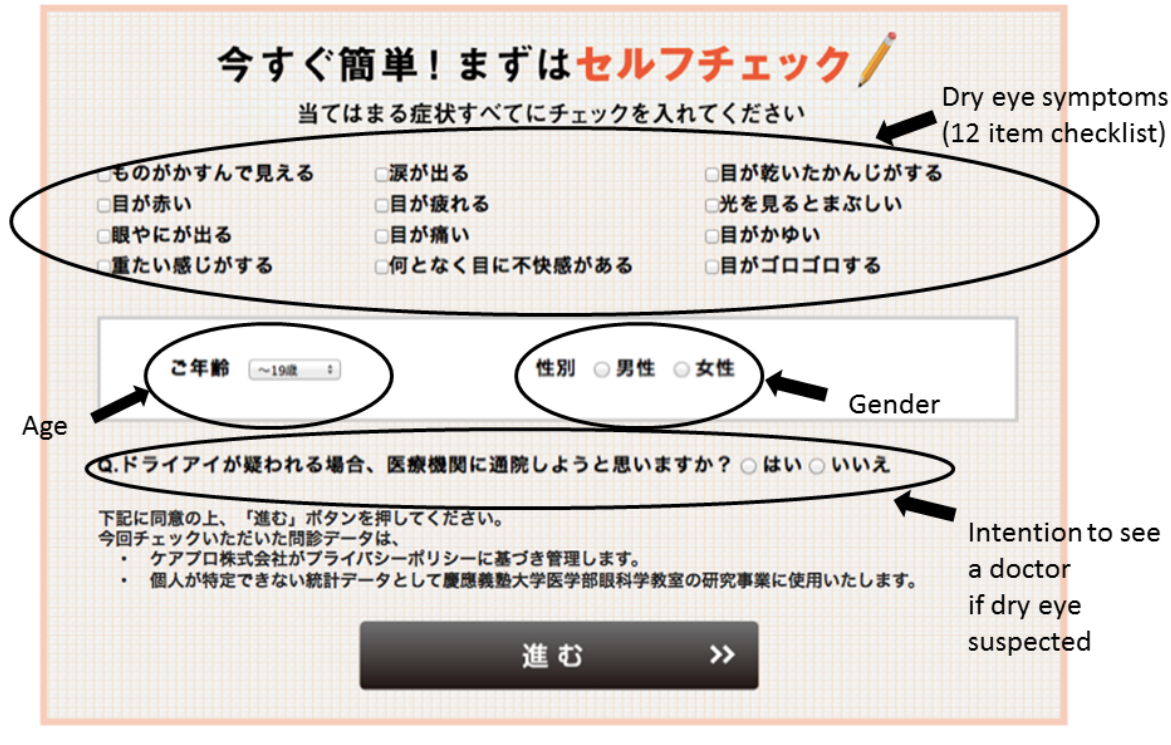
Figure 1. Web-based self-screening